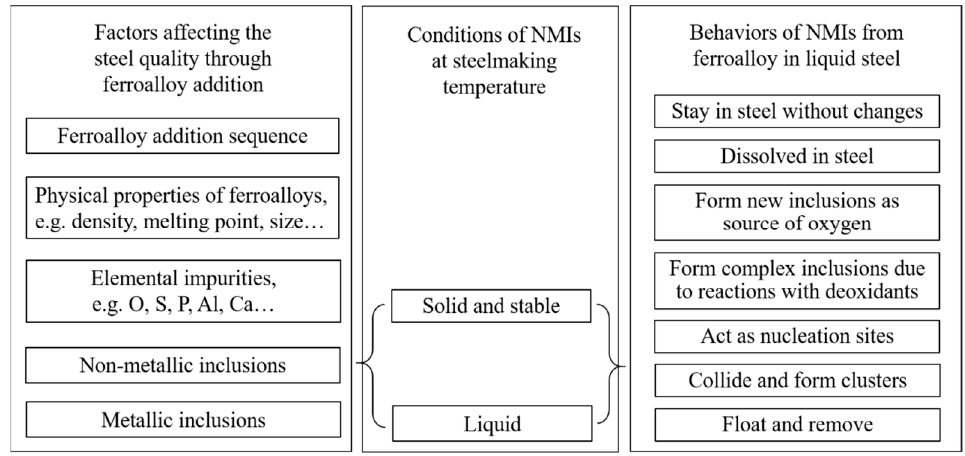
Figure 8. The possible effect of ferroalloy additions on the quality of steel cleanliness.